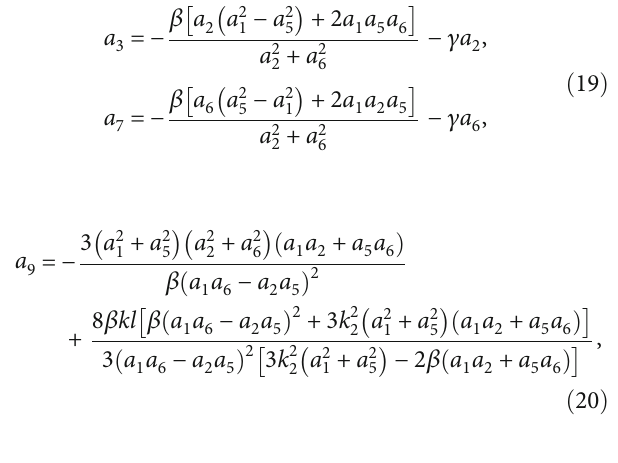
Figure 4: The three-dimensional plots of the mixed solution equation (23) with a = 1 , and a = a = 0 : (a) t = − 100 ; (b) t = − 25 ; (c) t = 0 ; (d) t = 25 ; (e) t = 100 − σ 2 4 8